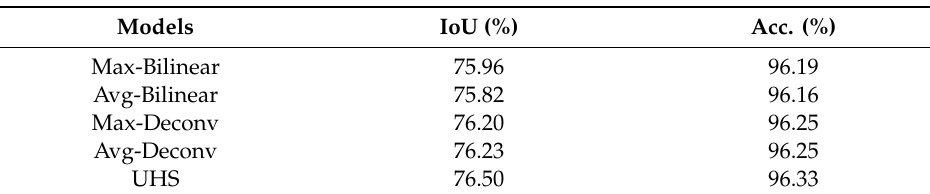
Table 2. Evaluation of Web-Net for the validation set.